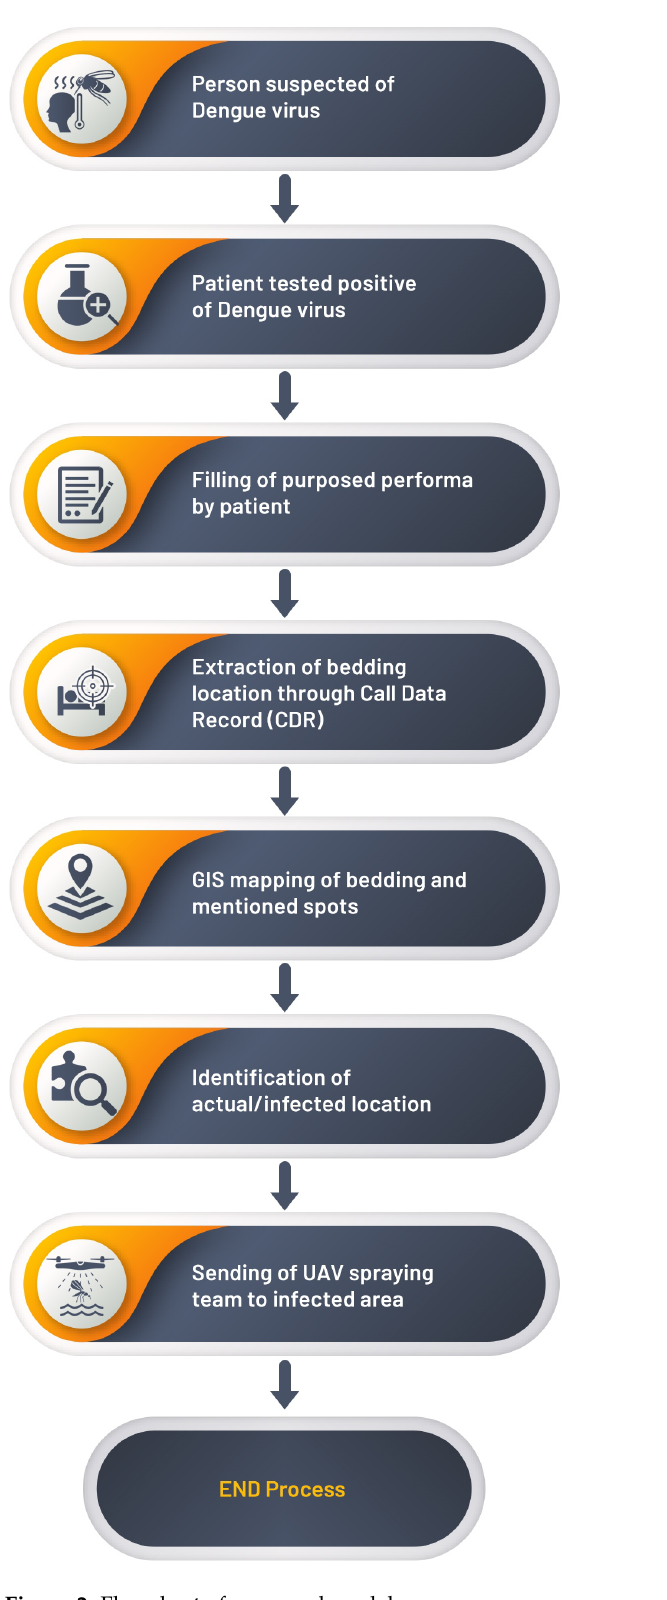
Figure 2. Flowchart of proposed